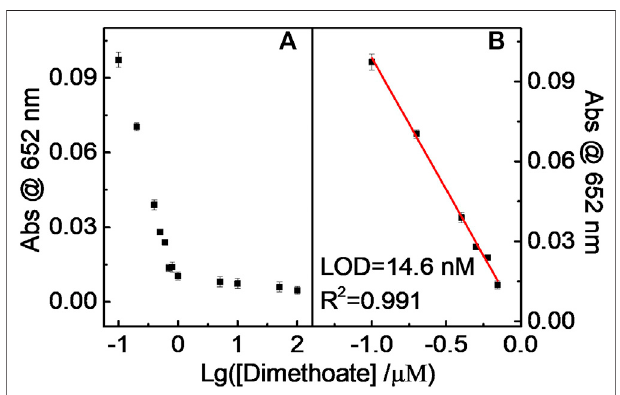
FIGURE 11 | Relationship (A) and the linear fi tting (B) between Abs at 652 nm and Lg (dimethoate).